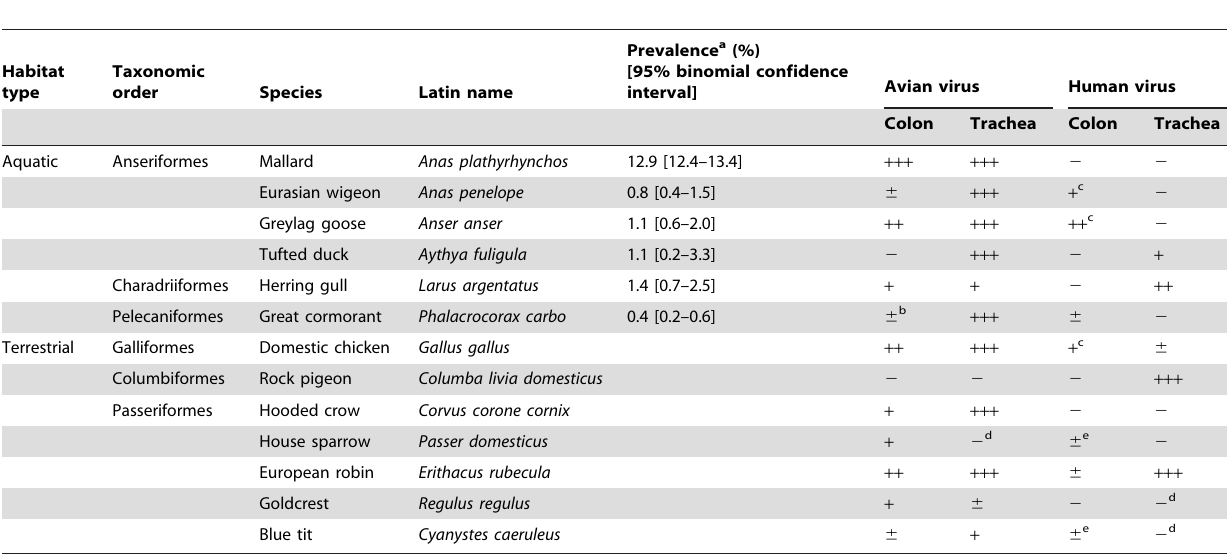
Table 1. Pattern of virus attachment of an avian influenza virus and a human seasonal influenza virus in the trachea and colon of 12 wild bird species and domestic